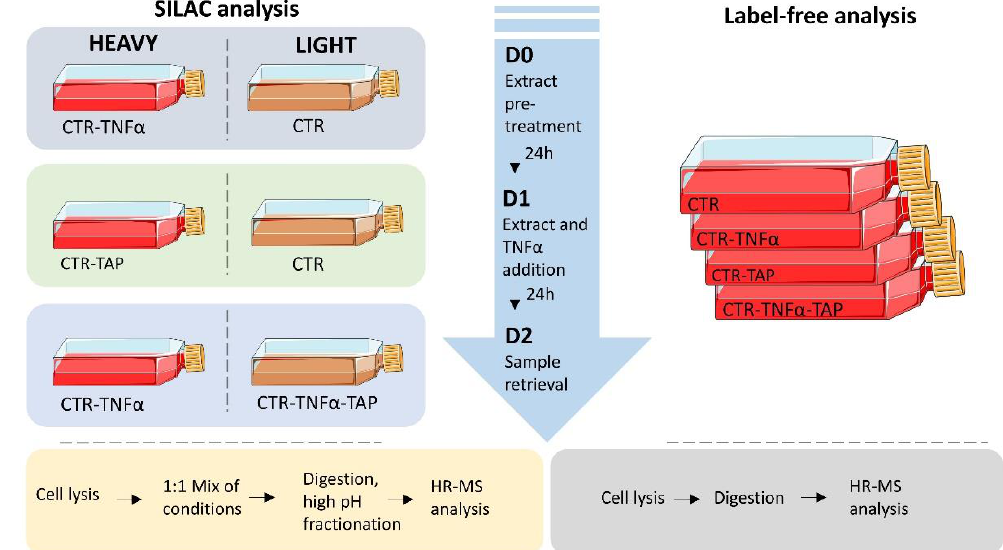
Figure 1. Experimental design of the quantitative proteomic analysis based on the two orthogonal approaches applied, namely, SILAC ( left side ) and LFQ ( right side ), interspersed by a timeline describing the three basic treatment steps. Below is a schematic of the sample processing protocol.